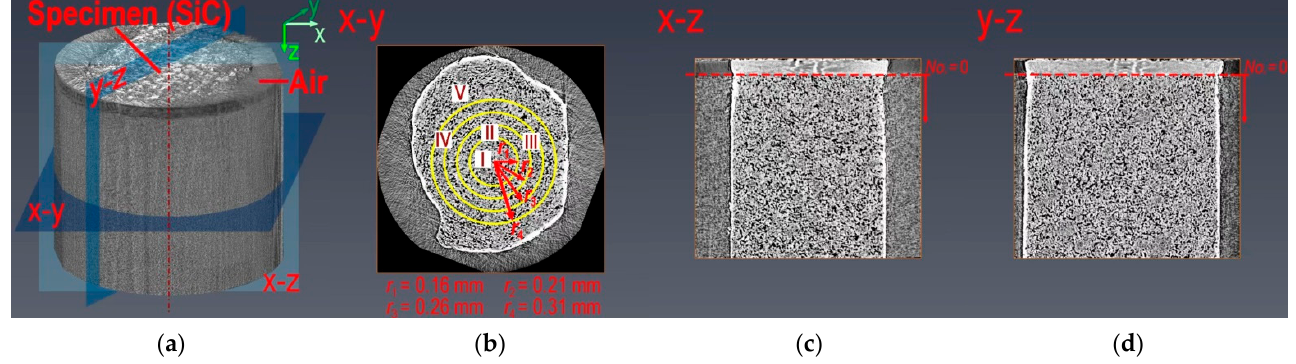
Figure 4. A 3D picture and its different planes of half of the specimen coated by the SiC. ( a ) 3D picture; ( b ) x-y plane; ( c ) x-z plane; ( d ) y-z plane.